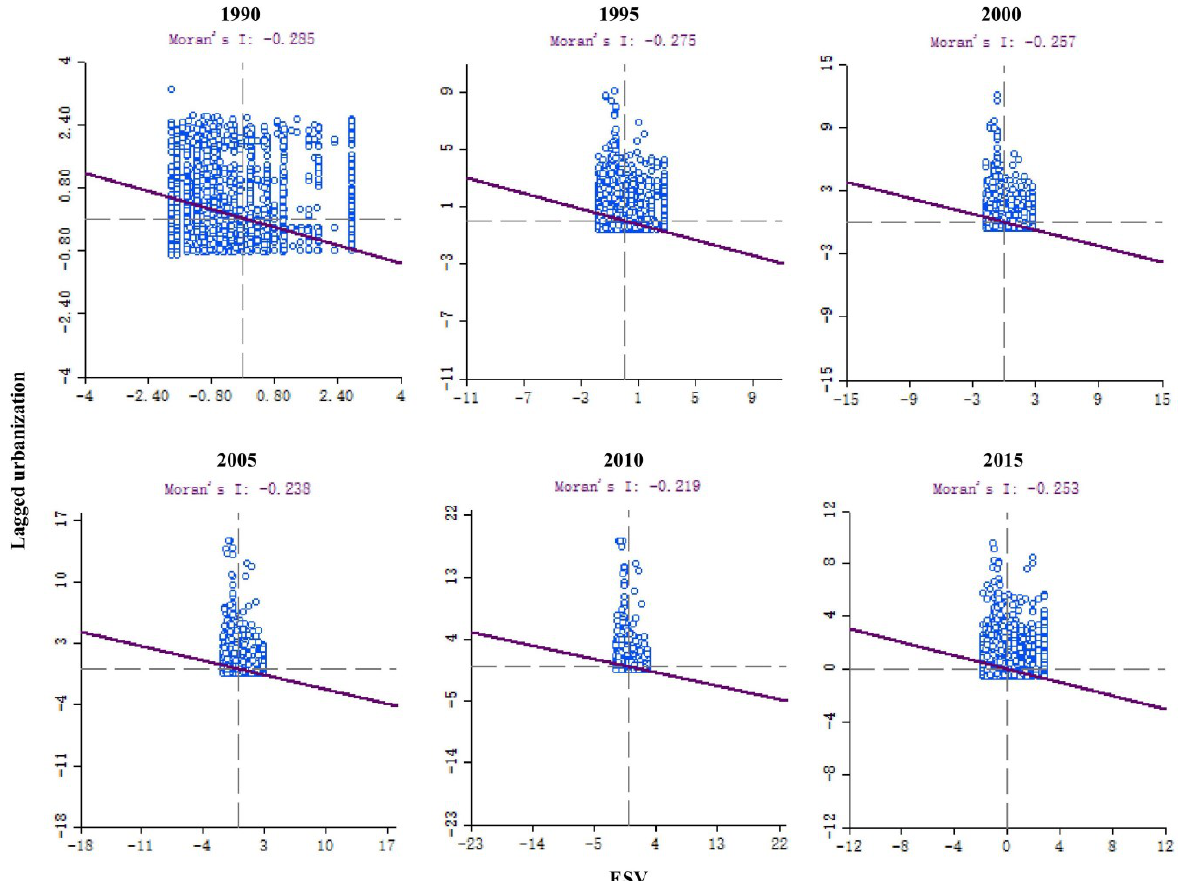
Figure 5. Moran’s I Index of ESV and urbanization in Shannan from 1990 to 2015.